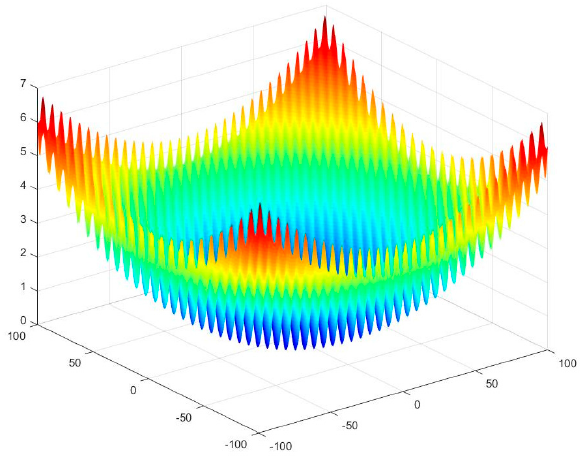
Figure 7. Three-dimensional image of Griewank function ( f 5 ).